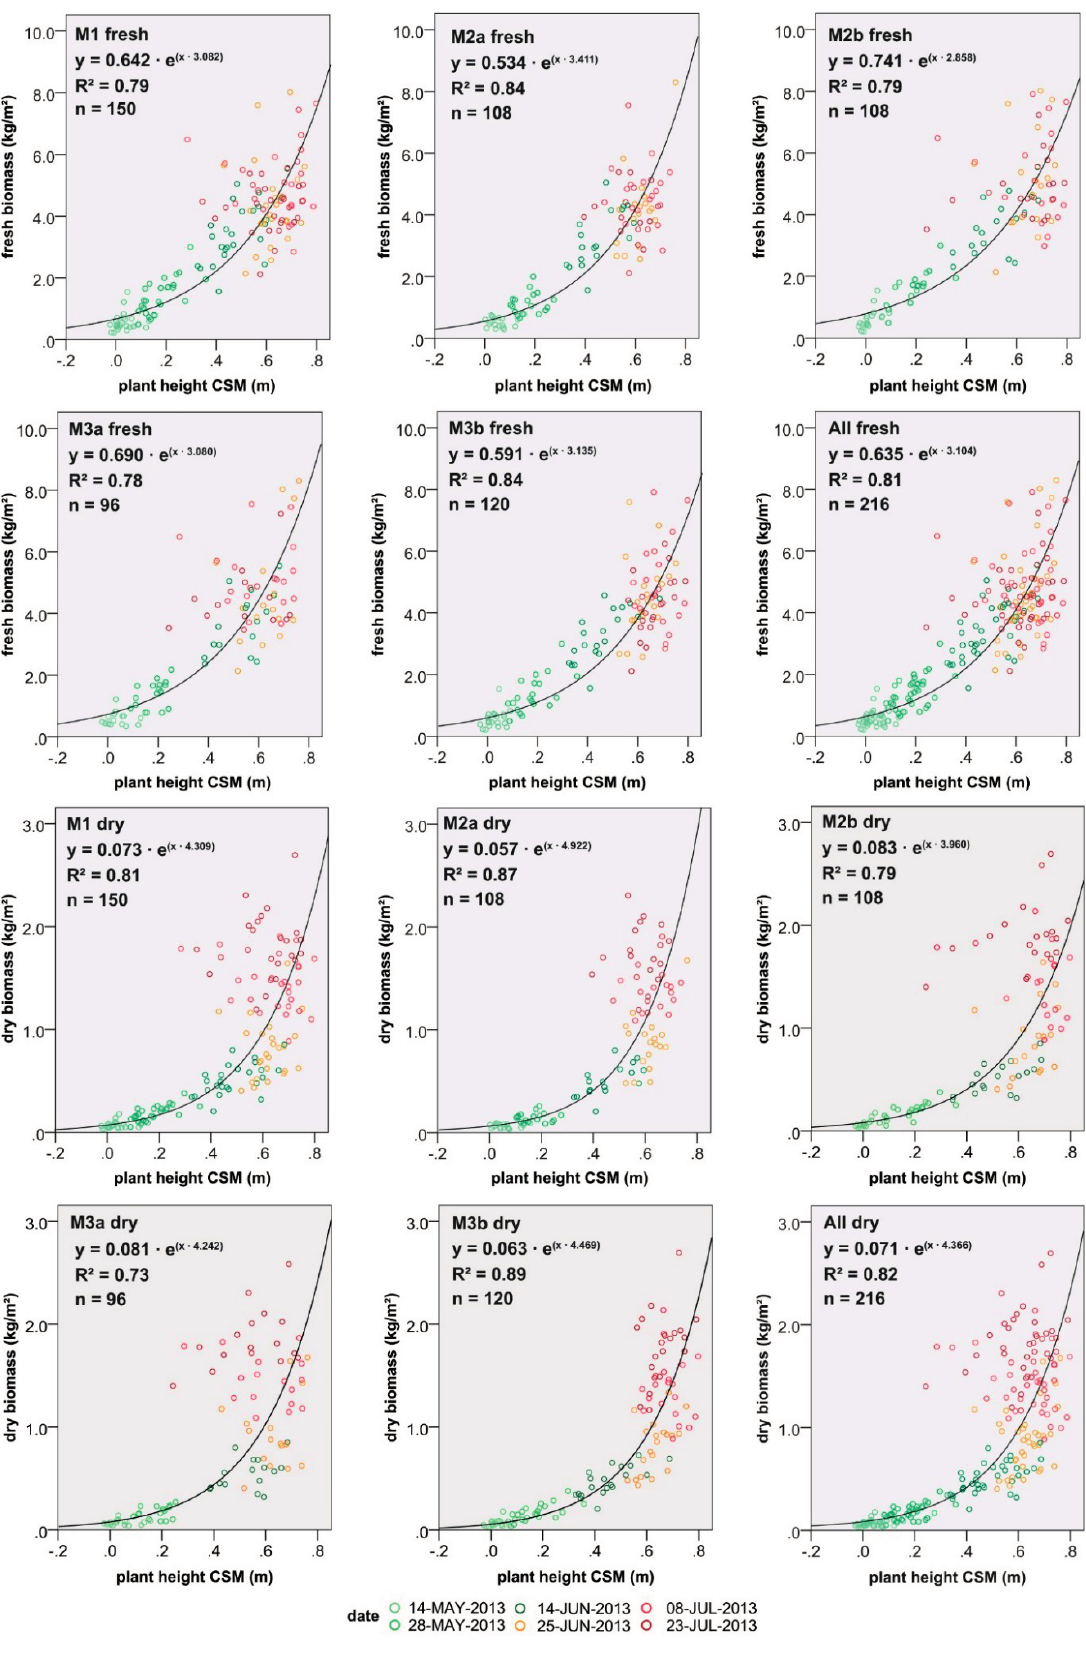
Figure 4. Cross-validation relationship of fresh/dry biomass and CSM datasets. Model 1 (M1): 70%; M2a: 40 kg N/m 2 ; M2b: 80 kg N/m 2 ; M3a: old cultivars; M3b: new cultivars and all values; p < 0.0001 for all R 2